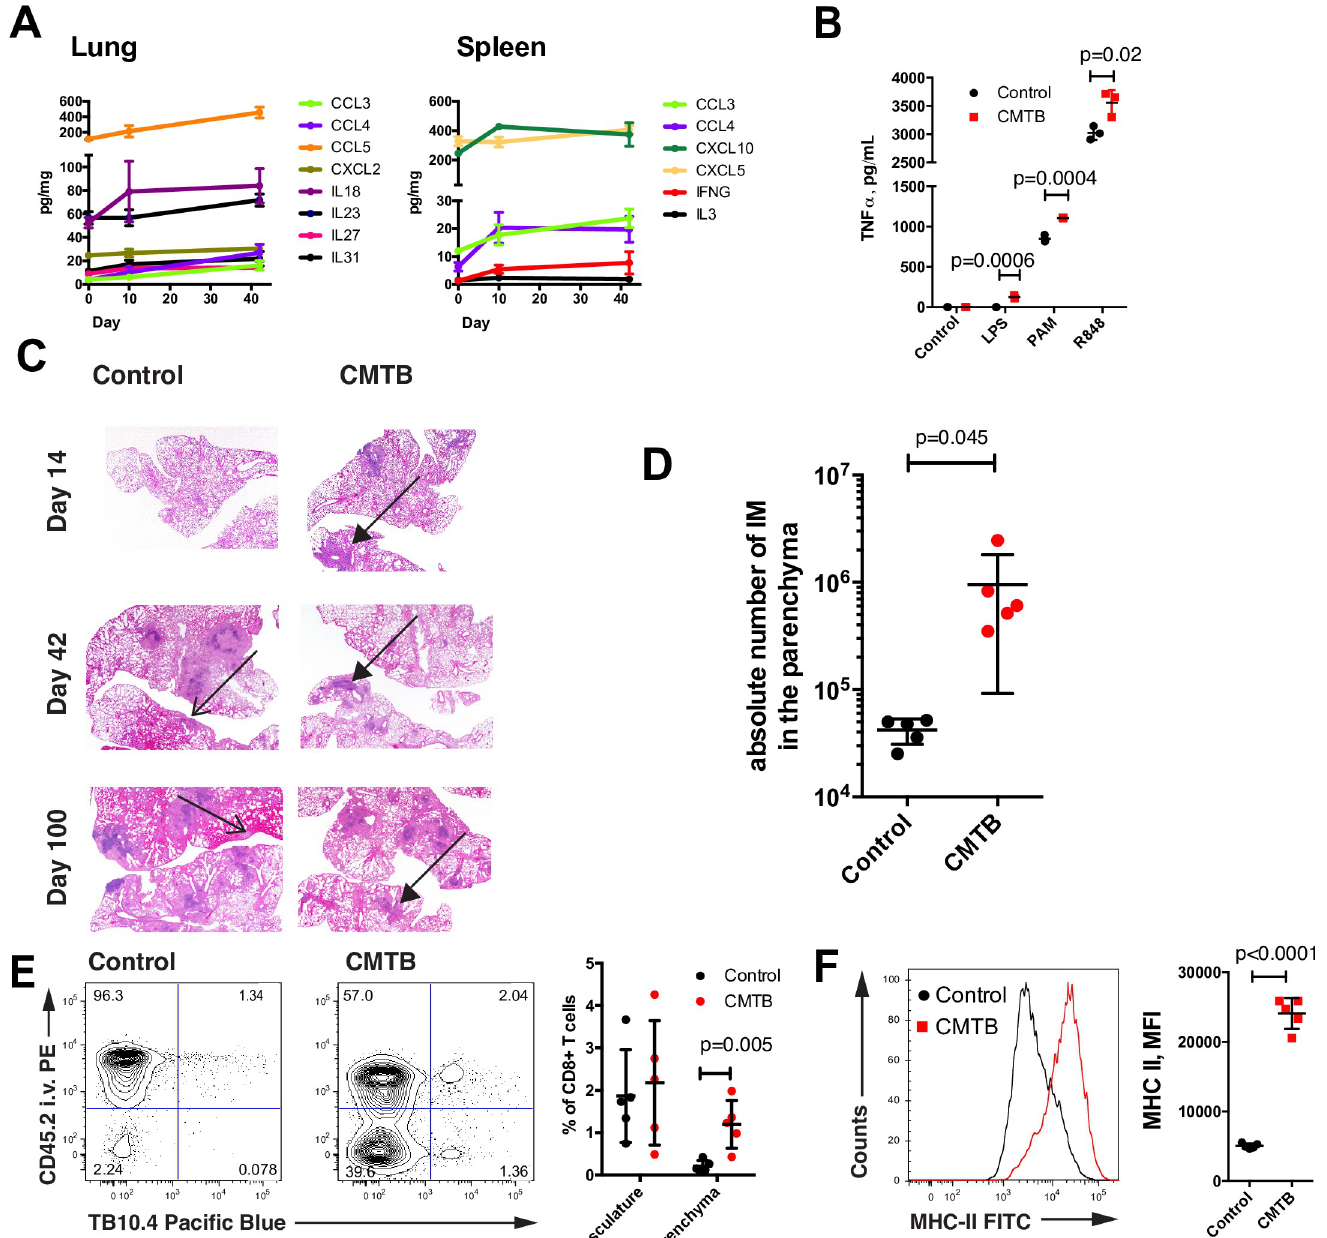
Fig 3. The protective phenotype in CMTB mice is associated with elevated tissue inflammation and an early immune response. ( A ) Tissues were isolated 10 or 42 days following the establishment of CMTB or from control mice (plotted at day 0). Absolute levels of cytokines and chemokines significantly altered by CMTB during at least one time-point in the lung or spleen (of 38 assayed) are plotted. Cytokine/chemokine amounts were normalized to total protein ( n = 5 mice per time- point). A multiple t -test approach with Benjamini-Hochberg correction was used to test for significance (p < 0.05 for all analytes shown). ( B ) CD11b+ cells isolated from the lungs of CMTB or control mice were stimulated for 6 hours with the indicated TLR agonists and secreted TNF measured by ELISA (LPS 10 ng/mL, PAM3 300 ng/mL, R848 100 ng/mL). Data are representative of three independent experiments with cells from 3–5 mice pooled per condition. Points indicate technical replicates and significance was assessed by Student’s t -Test. Error bars depict the mean and SD. ( C ) Haemotoxylin and eosin stained lung sections from control and CMTB mice at the indicated time-points following aerosol challenge. Regions of infiltration by immune cells (filled arrow heads) and intrapulmonary hemorrhages (open arrow heads) are indicated. The corresponding quantitative pathology assessments are presented in S1 Table. Representative images from 5 mice per condition are displayed at 2 × . ( D ) Quantification of relative number of CD11b + CD11c + CD64 + Siglec-F - monocyte derived macrophages in the lung parenchyma in control and CMTB mice at 14 days following aerosol infection with 100 CFU of Mtb H37Rv. Data are representative of two independent experiments with mice (n = 4–5) per condition. Statistical significance was determined by Student’s t -Test. Error bars depict the mean with SD. (See S19 Fig for gating strategy).). ( E ) Representative cytometry plot and corresponding quantification of CD3 + CD8 + TB10.4 + cells in the vasculature (CD45.2-PE + ) and lung parenchyma (CD45.2-PE - ) in control and